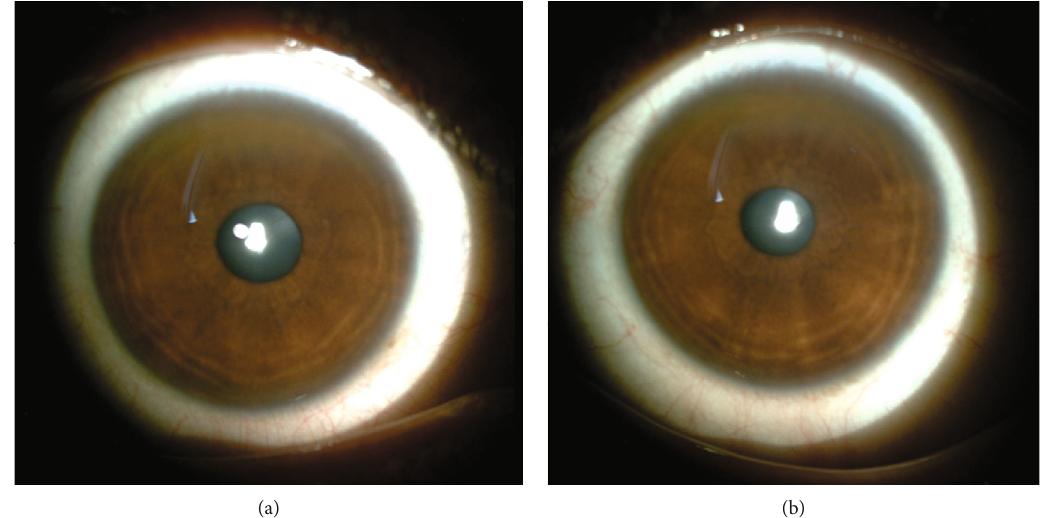
Figure 2: Slit-lamp photograph of the right eye (a) and the left eye (b) postoperation shows K-F ring in peripheral cornea, and the central area is